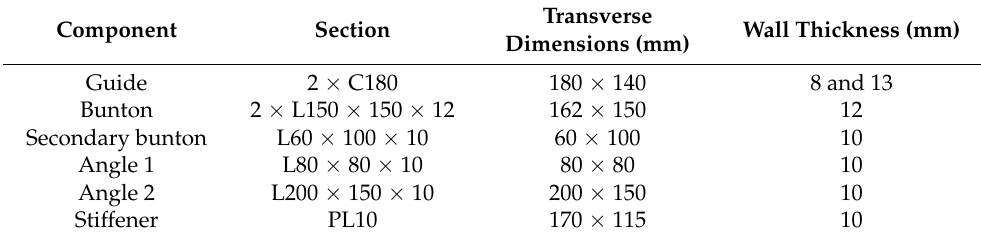
Figure 7. Views of the model from the ( a ) front, ( b ) side, and ( c ) top. Table 1. Geometry of model